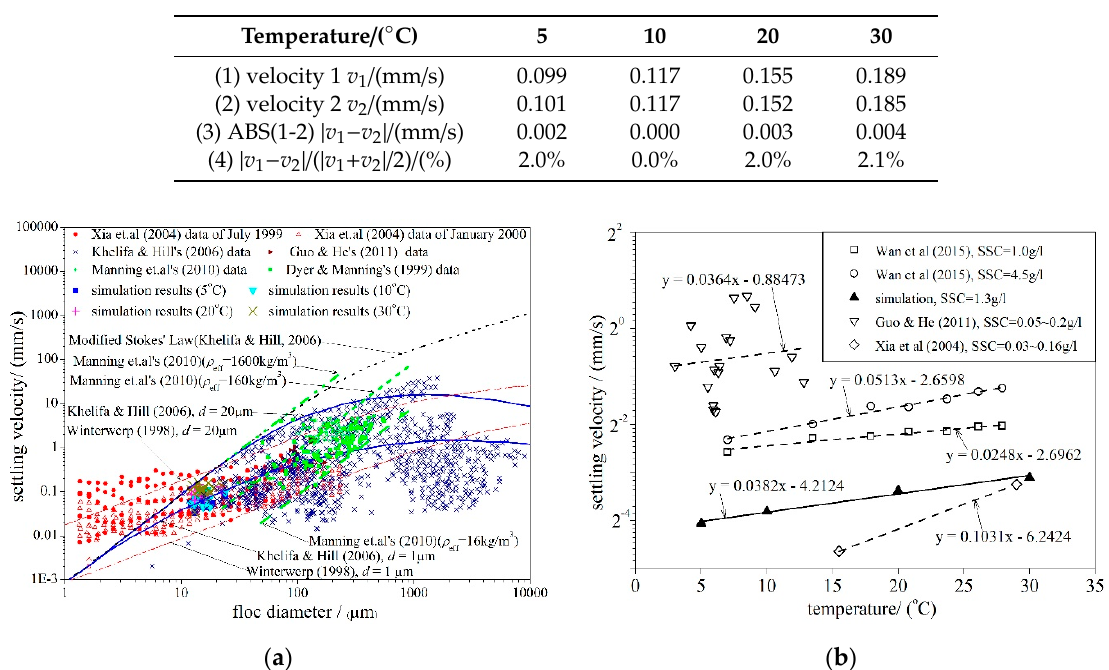
Figure 8. The settling velocities of flocs of different diameter and temperature in many studies. ( a ) Floc diameter and settling velocities from the observational data of Xia et al. [12], Khelifa and Hill [43], Guo and He [13], Dyer and Manning [42], and Manning et al. [43]; theory results of Manning